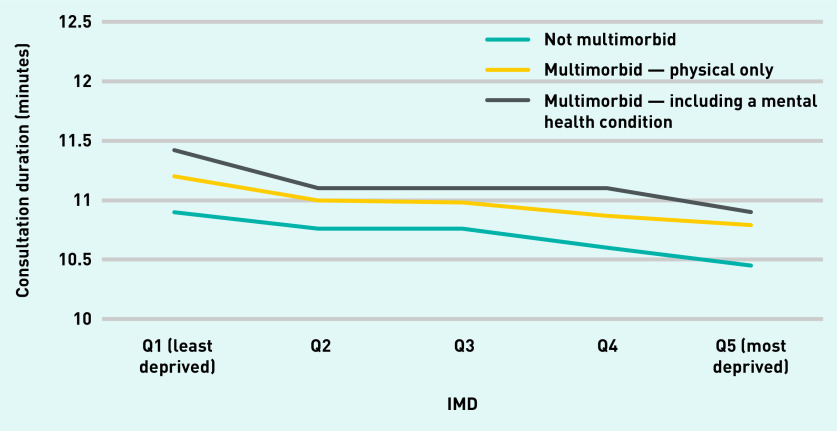
Consultation duration by Index of Multiple Deprivation and multimorbidity type: consultations lasting ≥2 minutes.aaNot multimorbid: 0–1 long-term condition; multimorbid — physical only: ≥2 physical conditions and no mental health conditions; multimorbid — including a mental health condition: ≥2 conditions with ≥1 mental health condition. IMD = Index of Multiple Deprivation. Q = quintile.